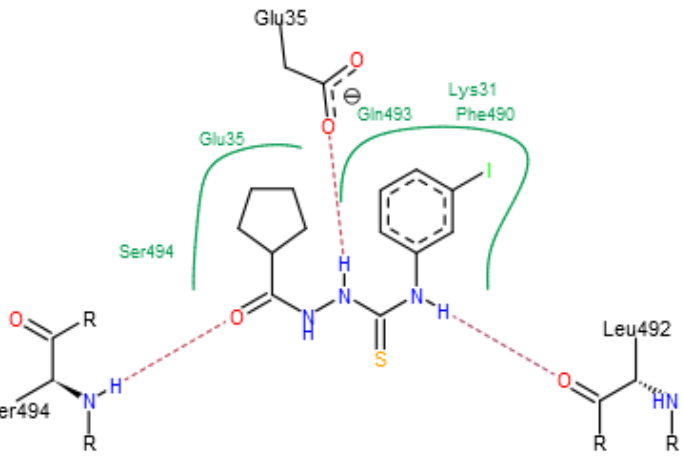
Figure 5. Interactions of CCmI in the binding groove of the interface.